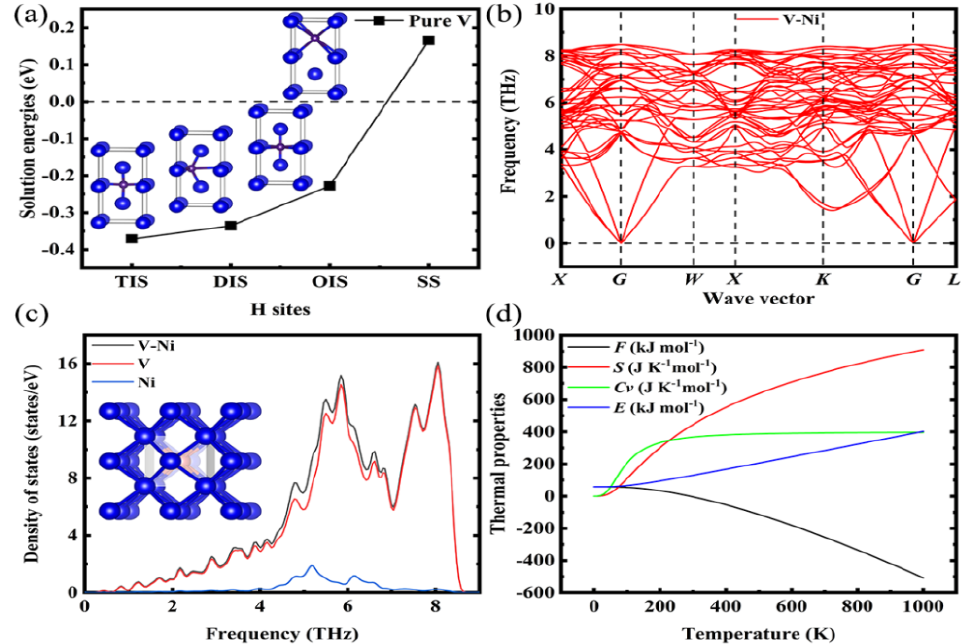
Figure 1. ( a ) Solution energies of H atom in interstitial and substitution sites for pure V; ( b – d ) phonon spectra and thermal properties of V–Ni solid solution alloy. The blue, red, and purple spheres represent V, Ni, and H atoms, respectively.